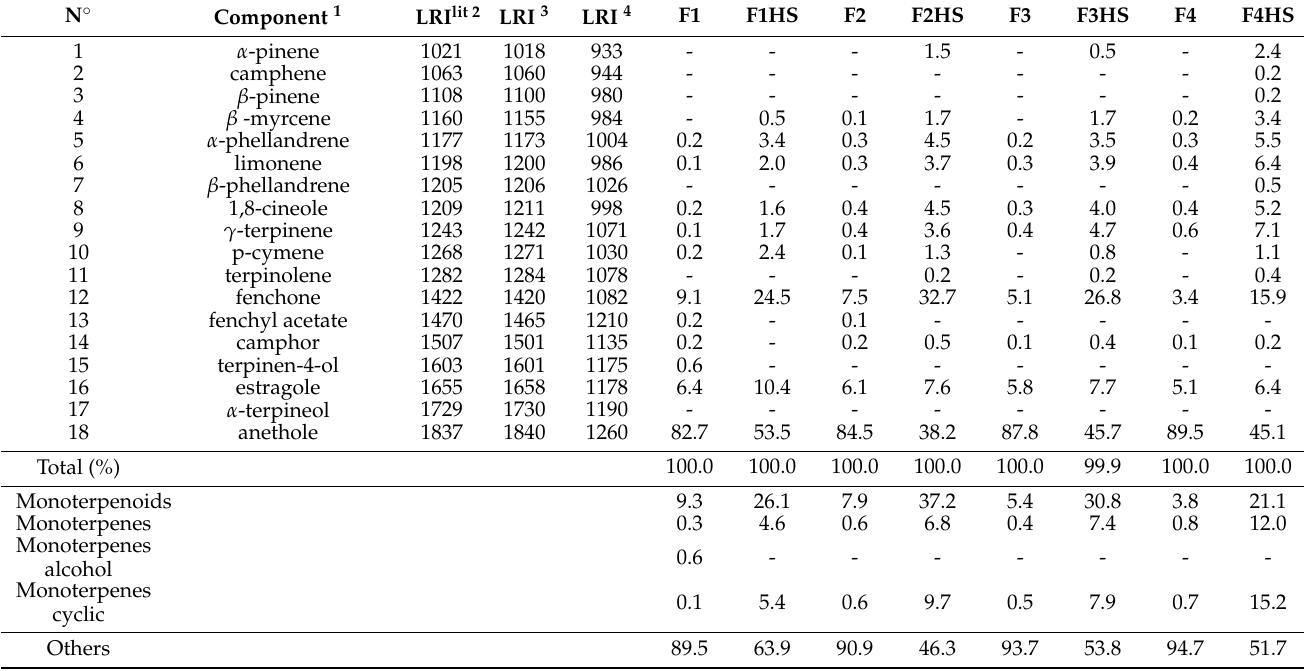
Table 2. Chemical composition (%) of FV essential oils (FVEOs) from Podgorica analyzed by GC/MS and HS-GC/MS.